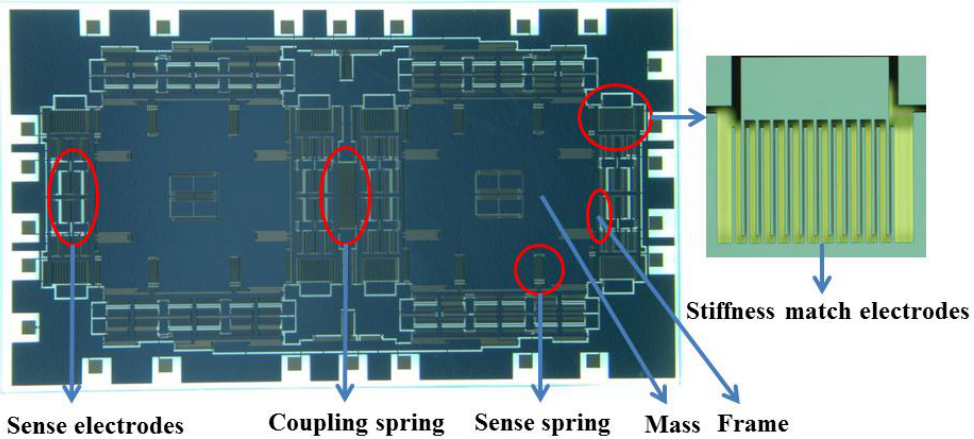
Figure 3. Optical photograph of a dual-mass tuning fork gyroscope.